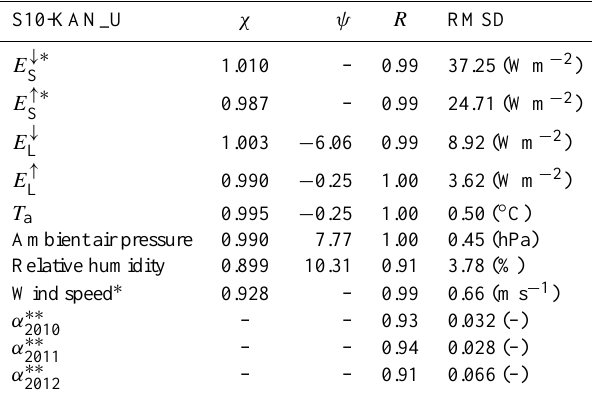
Table 2. Linear regression parameters for hourly values of KAN_U and S10 AWSs: slope ( χ ), intercept ( ψ ), correlation coeffi- cients ( R ), and root-mean-squared deviations